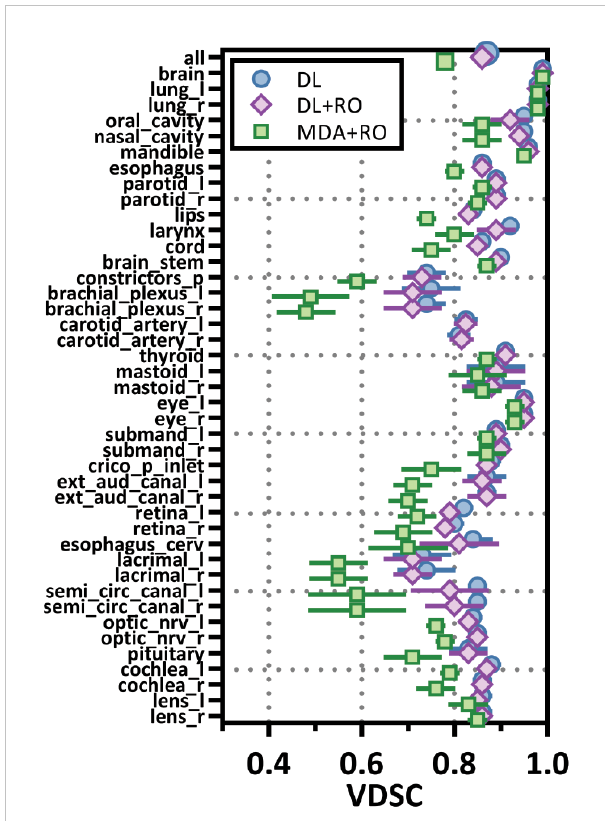
FIGURE 3 Mean volumetric Dice similarity coef fi cient (VDSC) and 95% con fi dence intervals for the unrevised deep learning (DL), radiation oncologist (RO) revised deep learning (DL+RO), and RO-revisions to the initial MDA contours (MDA+RO), categorized by organ-at-risk type and for all OARs. OARs listed in order of decreasing volume.